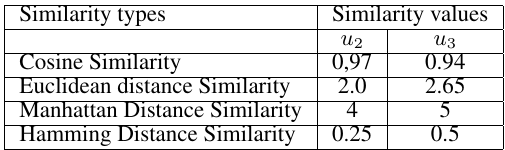
Table 4. Calculated similarity between